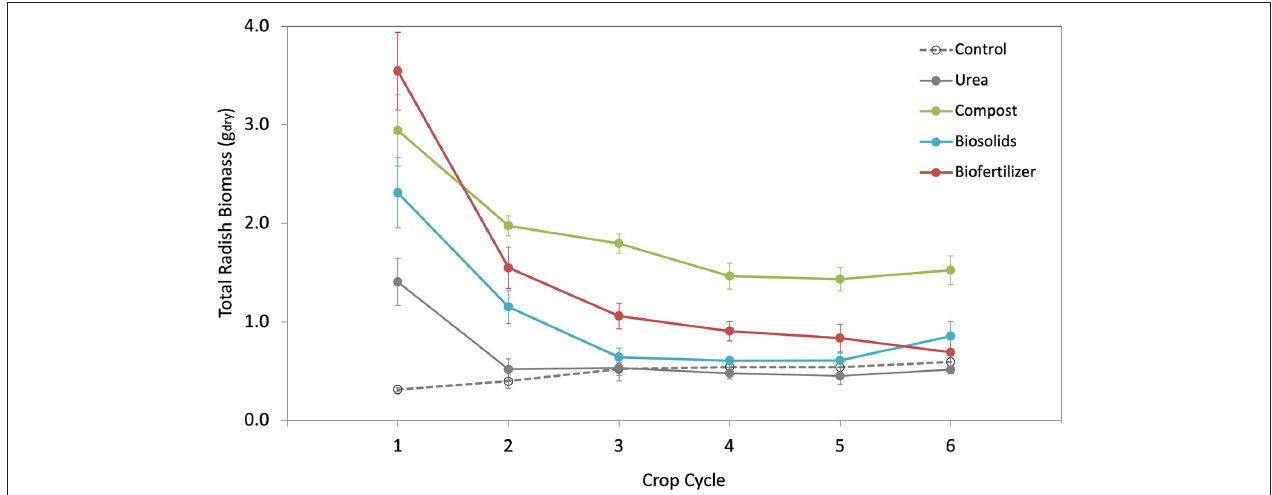
FIGURE 2 | Total plant biomass of six consecutive radish crop cycles. Treatments were added only one-time, prior to planting seeds in the first crop cycle. Symbols represent treatment means at the time of harvest, with ± standard error bars.